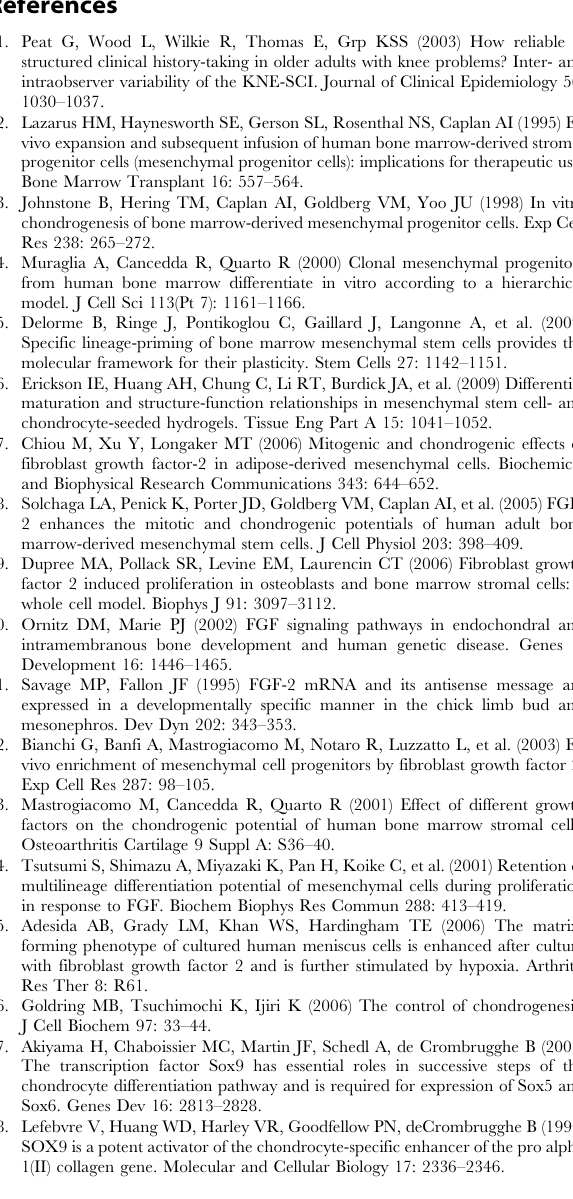
Table S1 List of end-point and real-time RT-PCR